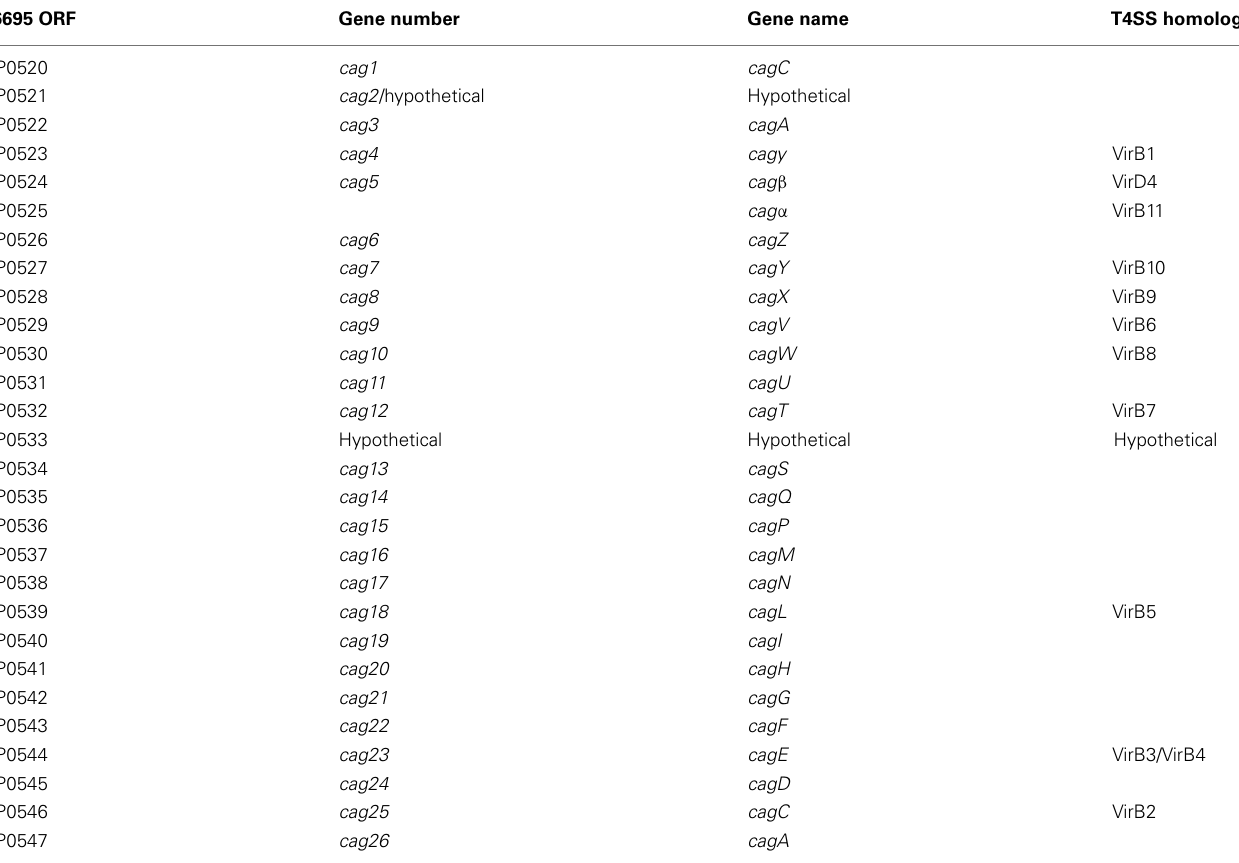
TableA6 | Key to cag PAI gene